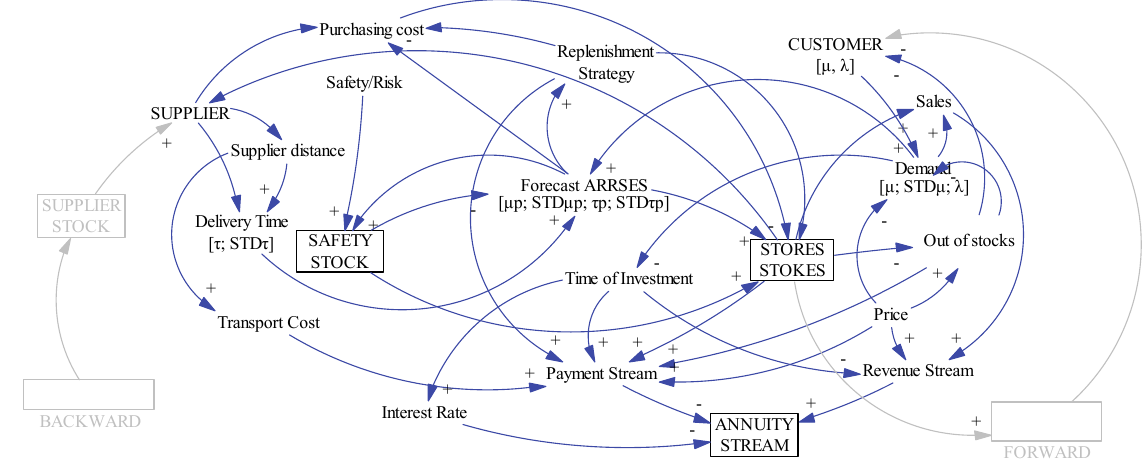
Fig. 8. CLD of generic echelon i of SC - Backward & Forward relation in grey